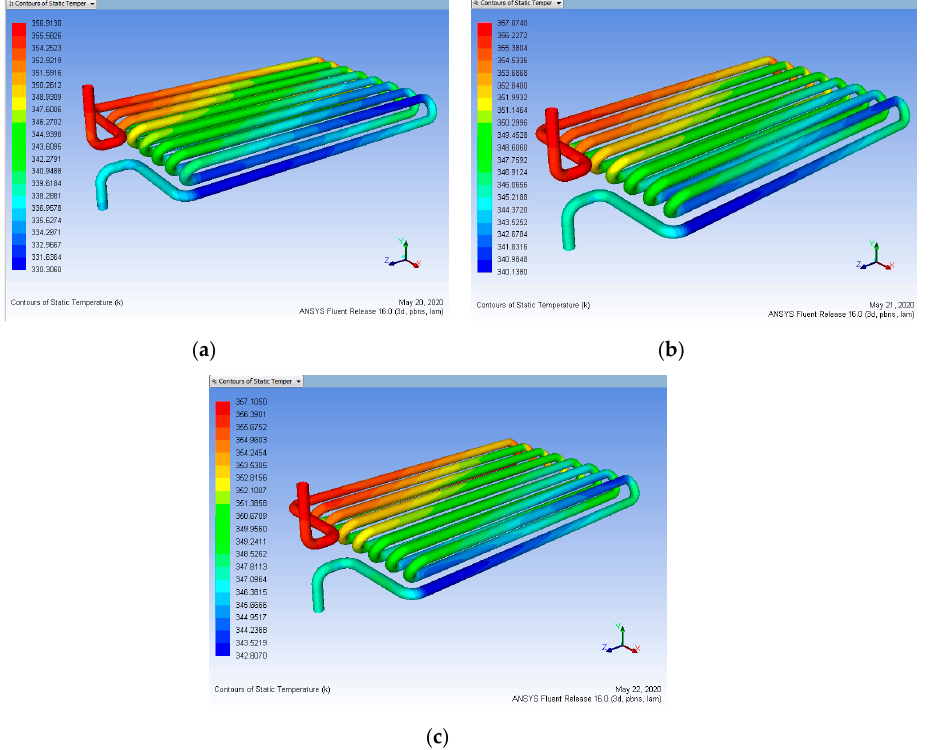
Figure 22. Heat input 363 K vs. Coating Thickness 50 µm for mass flow rate ( a ) 0.15, ( b ) 0.30, ( c ) 0.45 L/min (After Coating).